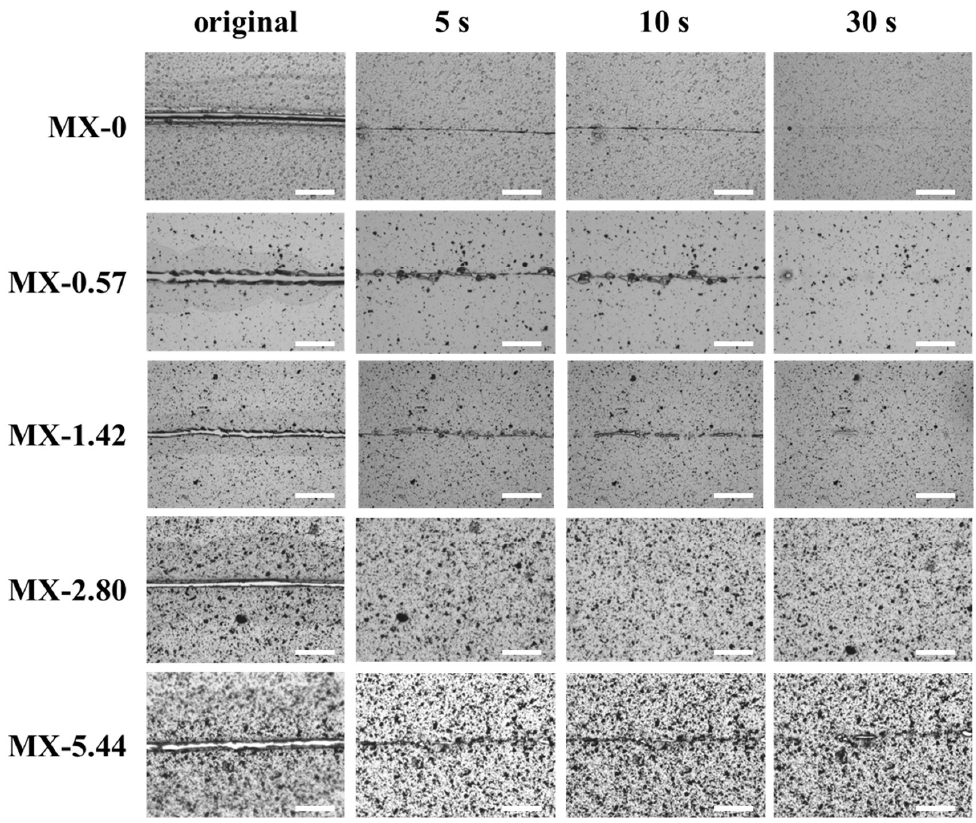
Figure 6. Optical images of MX-0–MX-5.44 coatings having cracks heating at 150 °C for different time periods. Scale bar = 100 μm.